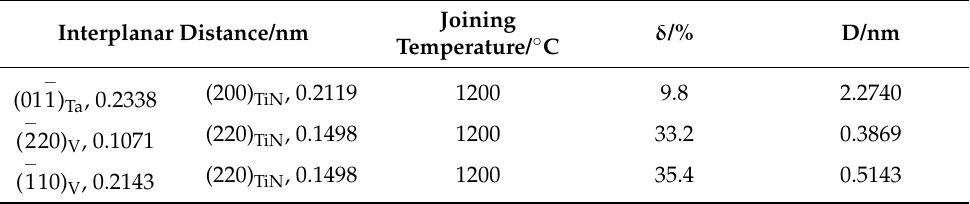
Table 8. δ and D values of parallel crystal planes in W/V/TiN/Ta composites. Interplanar Distance/nm